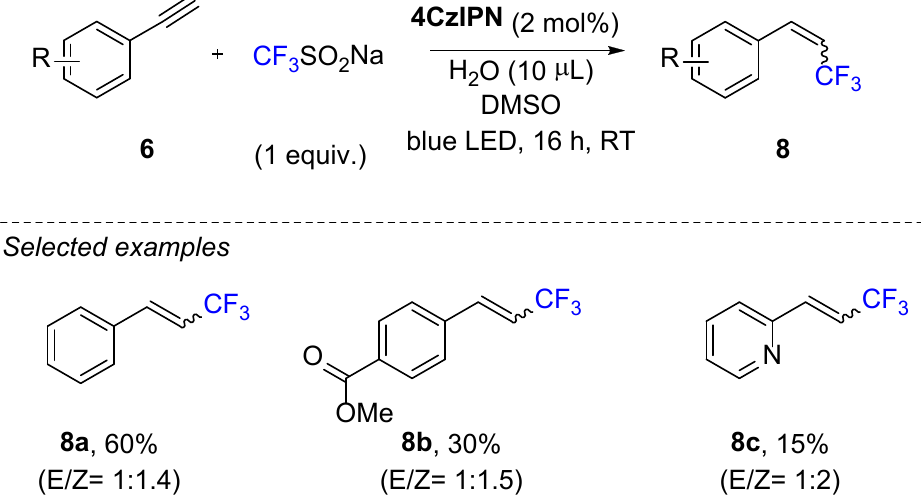
Figure 7. Hydrofluoroalkylation of styrenes developed by the group of Tlili.